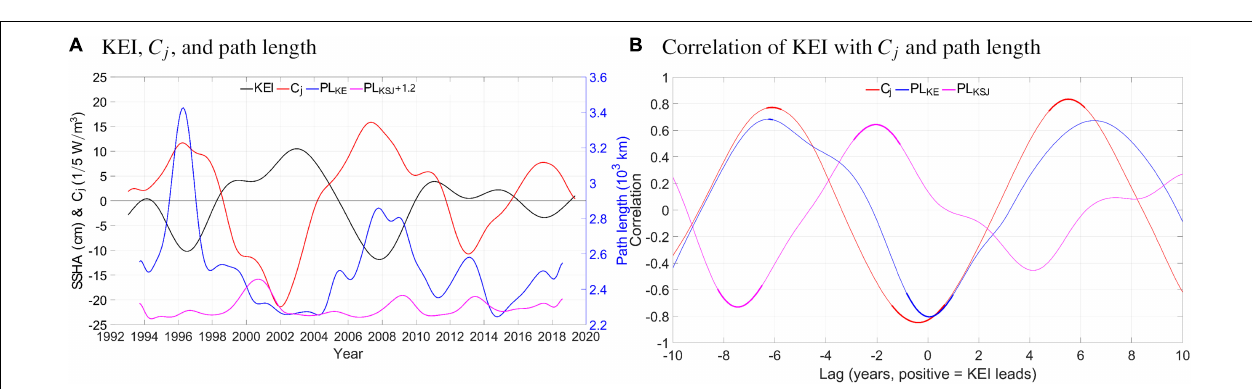
FIGURE 3 | Time-mean (thin contours) and difference between the ± KEI phases (shading) for (A) mean-flow kinetic energy (J/m 3 ), (B) eddy kinetic energy (J/m 3 ), (C) eddy-to-mean-flow kinetic energy conversion rate C ( K (cid:48) , K ) (W/m 3 ). Negative contours are dashed. Bathymetry of the Shatsky Rise is shown with the thick contours (CI = 1 km starting from 5 km).